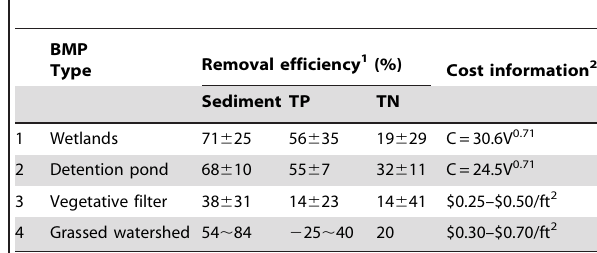
Table 2. The information for selected BMPs based on a database containing 275 BMPs.